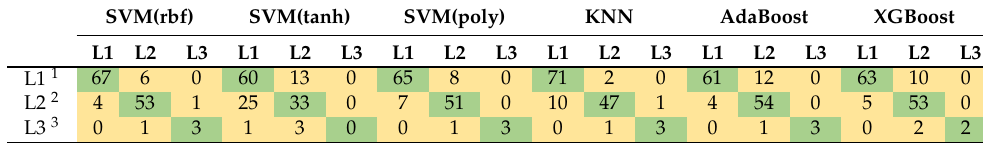
Table 4. The obfuscation matrixes of